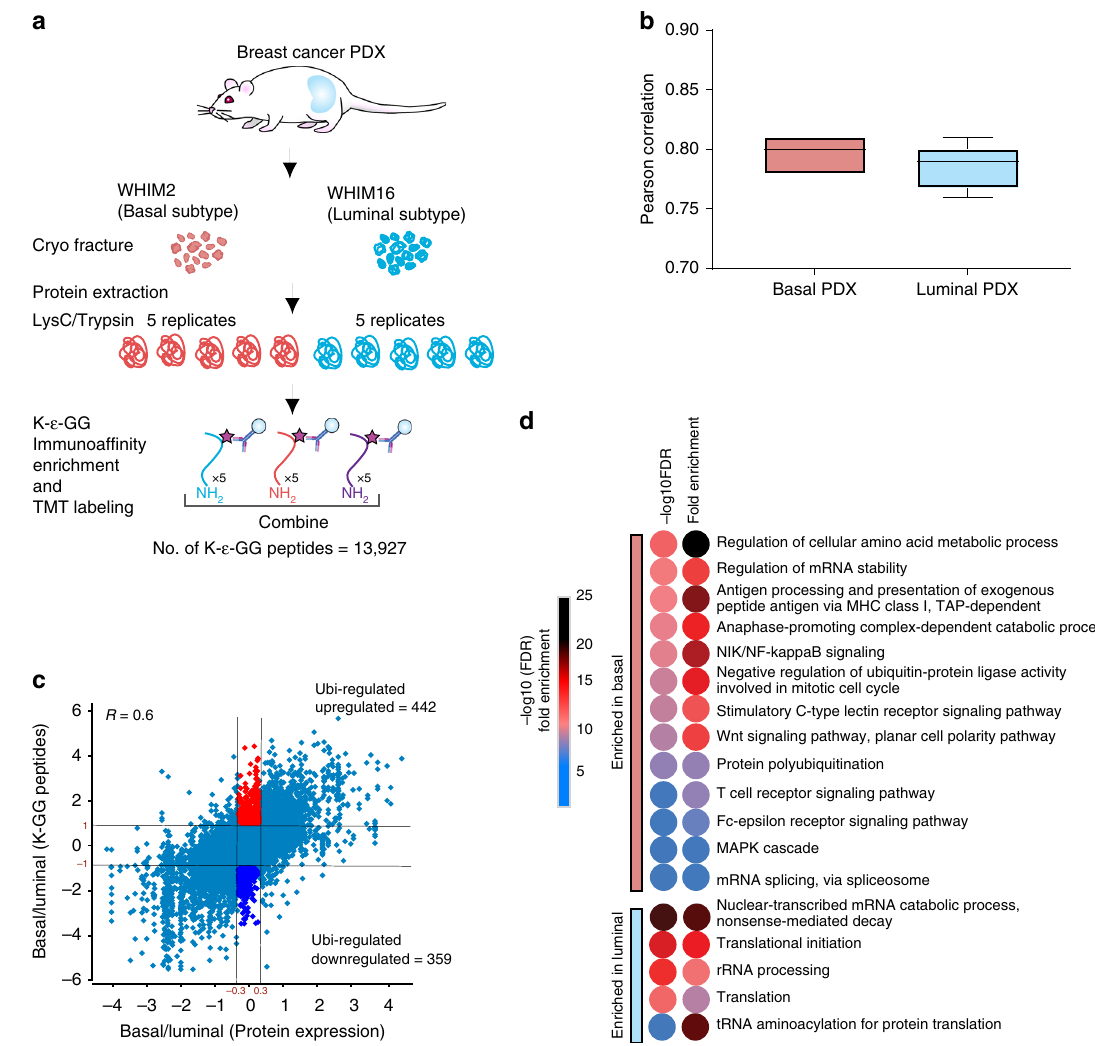
Fig. 3 Ubiquitylation analysis of breast cancer PDX models. a Schematic diagram showing experimental design used to enrich di-Gly modi fi ed peptides from the Luminal and Basal breast cancer PDX models. b Pearson correlation between Luminal and Basal PDX replicates ( n = 5 process replicates). Boxplot depicts upper and lower quartiles, with median shown as a solid line. Whiskers show 1.5 interquartile range. Source Data are provided in Supplementary Data 7a. c Scatter plot showing log2 fold-change between Basal and Luminal PDXs, for expression of ubiquitylated sites and the corresponding protein. The proteins that were upregulated or down-regulated exclusively at the level of their ubiquitylation are indicated by red or blue points, respectively. d Pathway enrichment of proteins regulated primarily at the level of